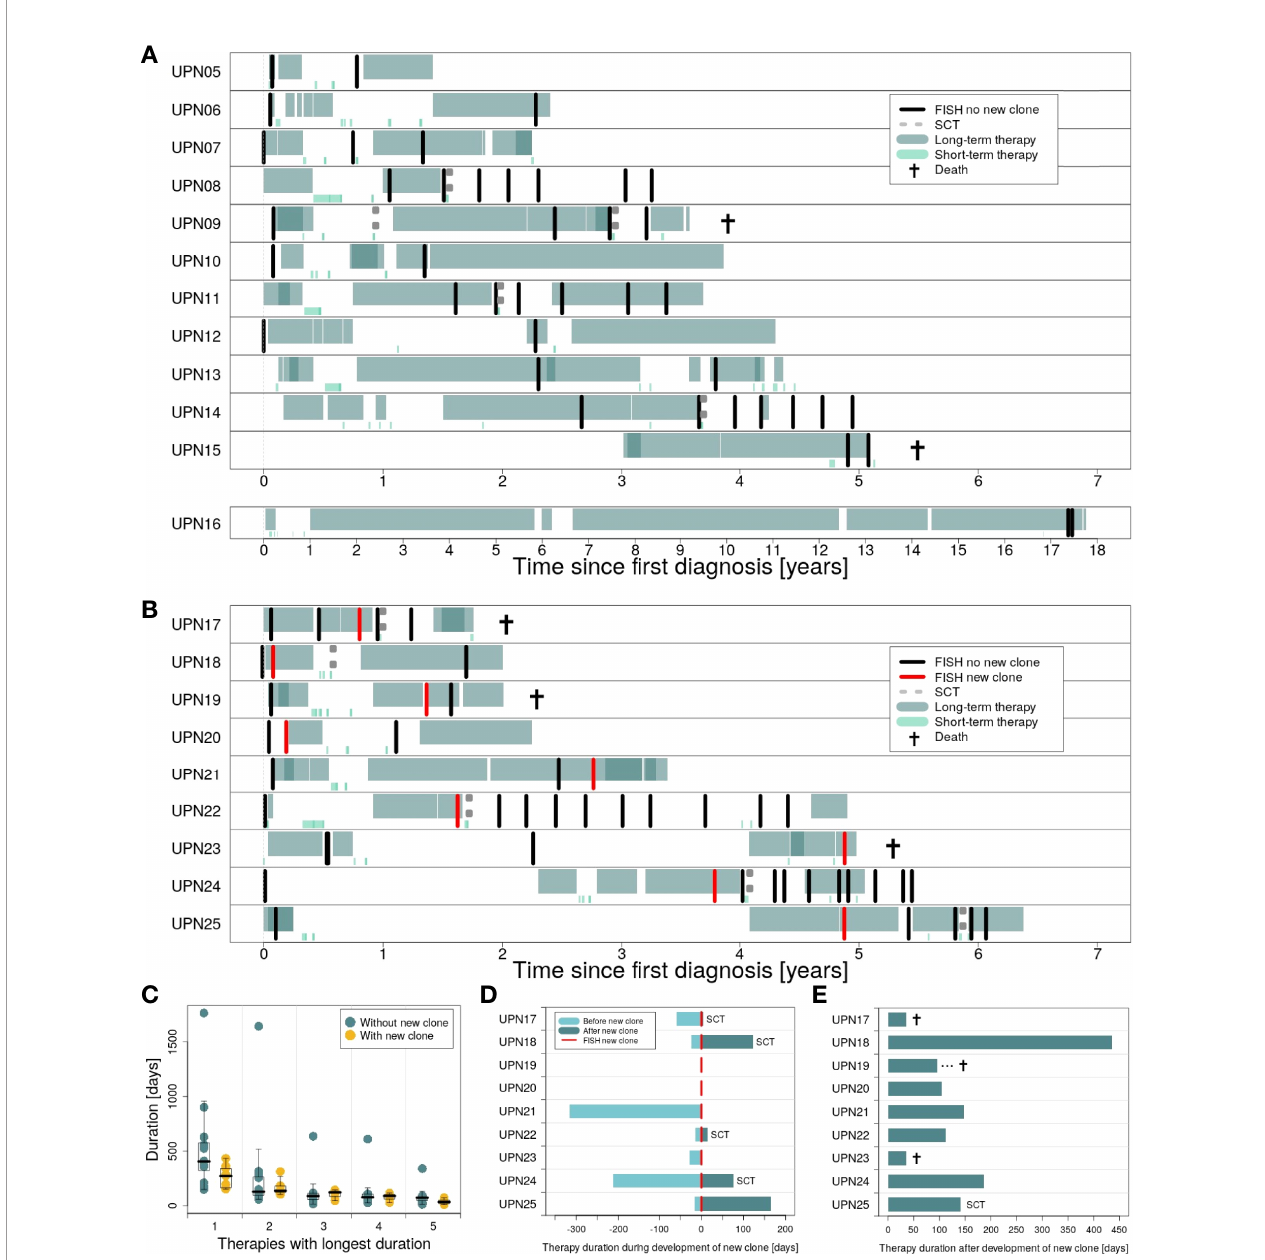
FIGURE 4 | Duration of therapies applied in the course of disease for patients in subgroups 1 and 2. (A) Long-term vs. short-term therapies for patients in subgroup 1 (patients UPN05 to 16). (B) Long-term vs. short-term therapies for patients in subgroup 2 (patients UPN17 to 25). (C) Therapies with the longest duration comparing subgroup 1 vs. subgroup 2. (D) Duration of therapies for subgroup 2, applied during development of the new clone. (E) Duration of the fi rst therapy applied after development of the new